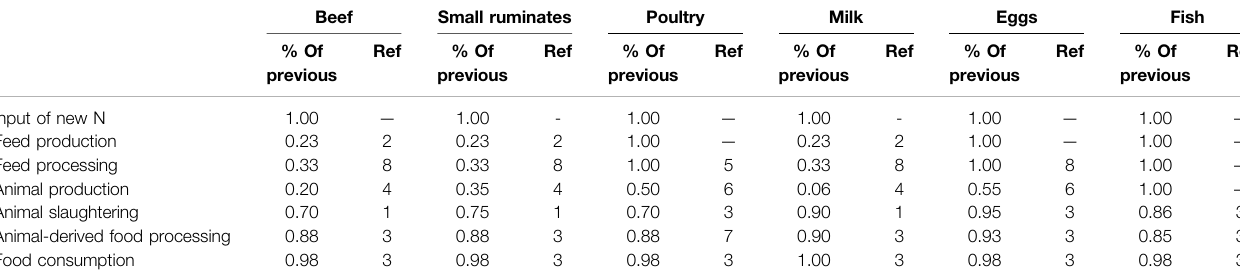
TABLE 2 | Parameters and references used for the calculation of the VNFs of Rwanda: livestock products. Beef Small